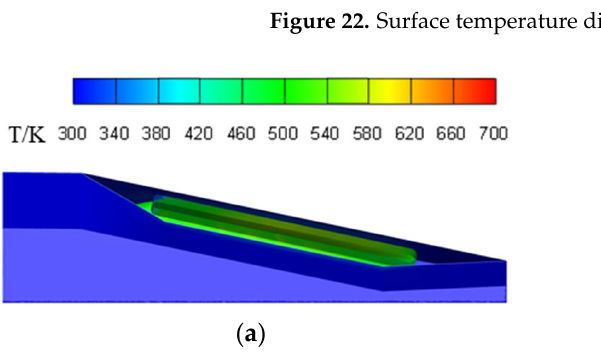
Figure 23. Temperature distribution at the bo tt om of rear Fuselage. ( a ) Model Ⅰ ; and ( b ) Model Ⅱ . Table 4. Pumping coe ffi cient and exhaust temperature of mixing duct.